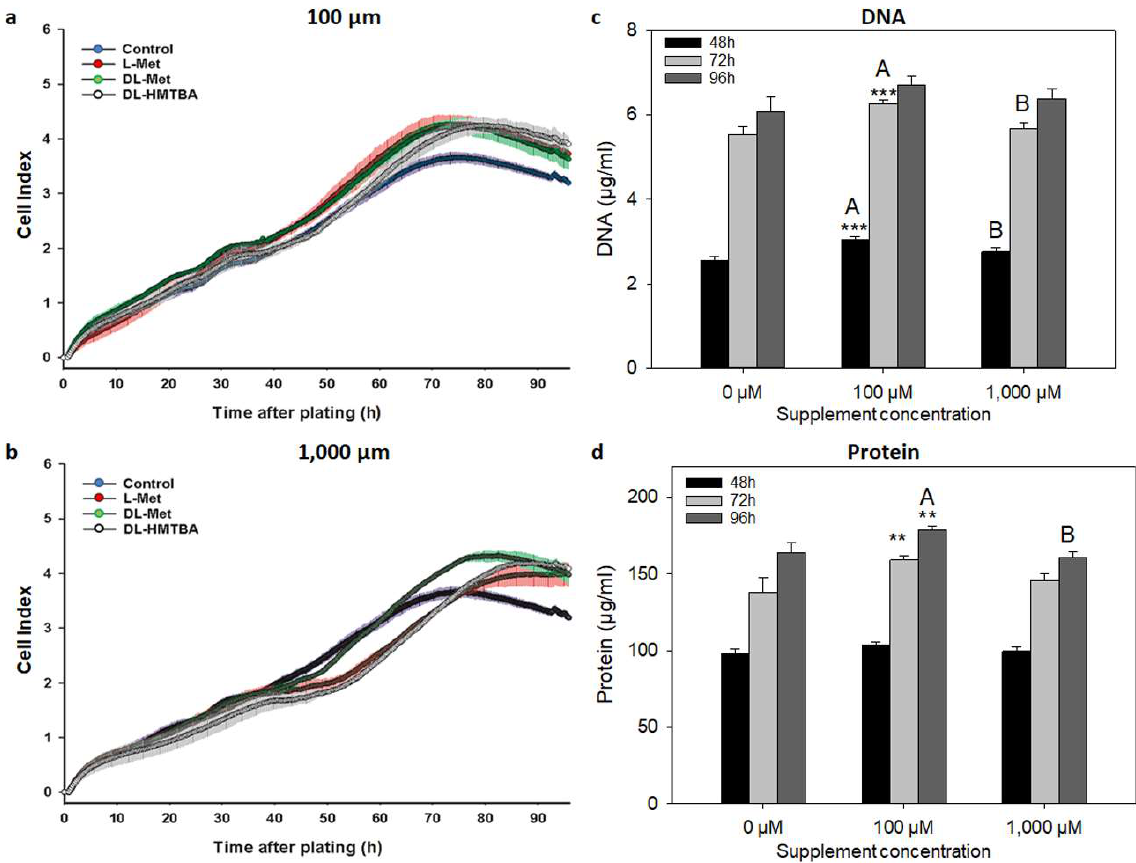
Figure 3. Effects of L-Met, DL-Met, and DL-HMTBA on growth kinetics ( a , b ) and DNA ( c ) and protein concentrations ( d ) of C2C12 cells. Representative kinetic growth curves for C2C12 cells (5000 cells/well) supplemented with 100 µM ( a ) or 1000 µM ( b ) of L Met, DL-Met, or DL-HMTBA are shown in comparison with controls without supplement. For the evaluation of DNA ( c ) and protein